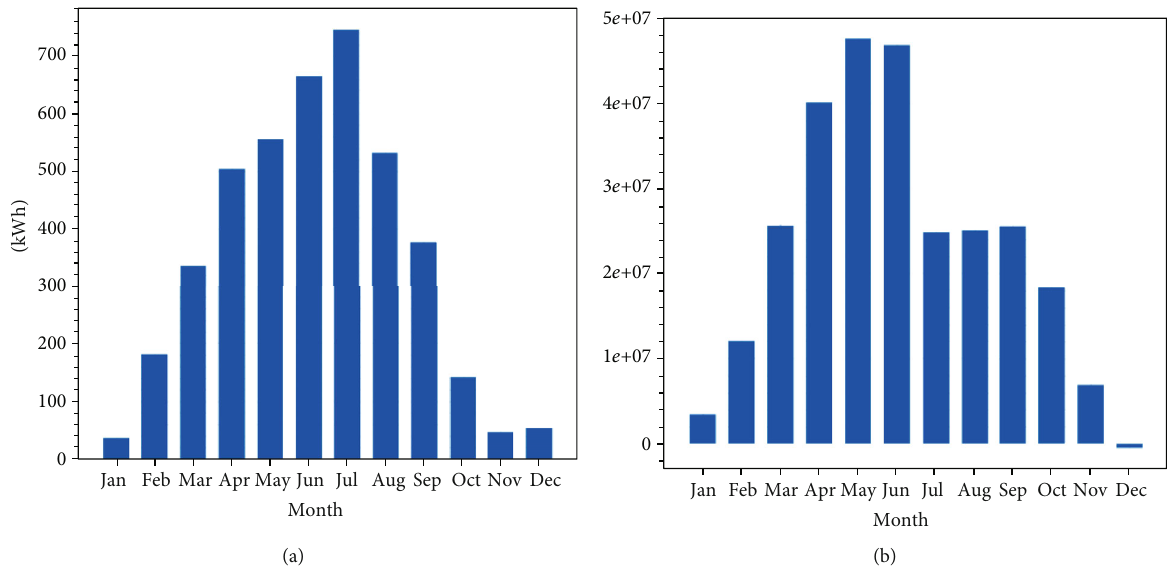
Figure 20: Monthly energy production (a) by the PV system and (b) by the CSP system.